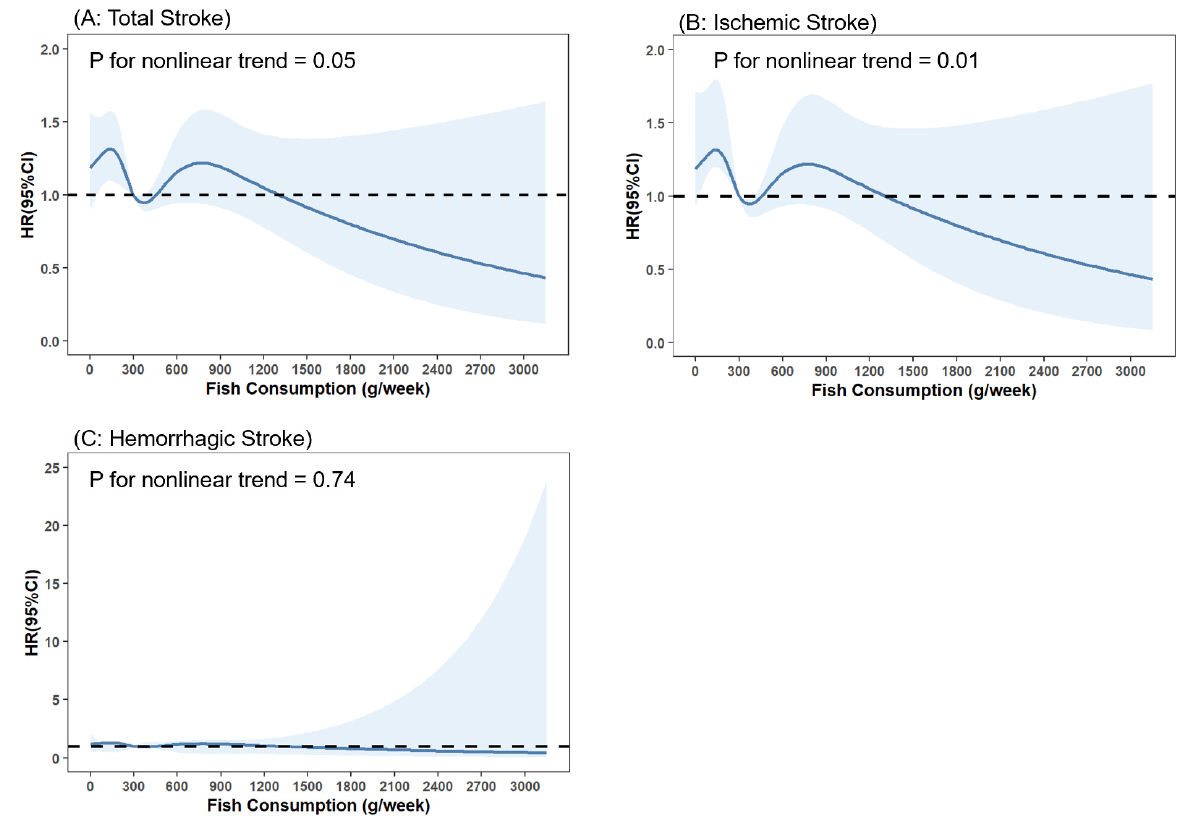
Figure 6. Association of fish consumption (g/week) with total stroke ( A ), ischemic stroke ( B ) and hemorrhagic stroke ( C ) in restricted cubic spline models. The model was adjusted for age, sex, educational levels, marital status, retirement status, smoking status, alcohol drinking status, physical activity levels, sleep qualities, obesity status, dietary energy intakes, consumption of fruit, vegetables, peanuts, wholegrains, processed and unprocessed meats, bean products, salt and oil, histories of chronic diseases, including hypertension, CHD, diabetes, CKD, dyslipidemia, HUA, HHcy, COPD, chronic bronchitis and asthma (the same as covariates in Model 3).